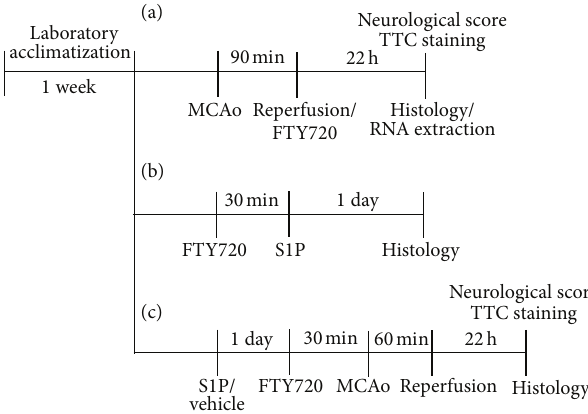
Figure 1: Schematic representation of experimental protocols. (a) Scheme for Figures 2 and 4 (an initial stroke model). Mice were challenged by 90min occlusion followed by 22 h reperfusion. FTY720 (3 mg/kg, i.p.) was administered to mice immediately after reperfusion. (b) Scheme for Figure 3. S1P was microinjected into the corpus callosum (CC) and brain samples were prepared 1 day after microinjection. FTY720 was administered 30 min prior to S1P microinjection. (c) Scheme for Figures 5 to 7 (a recurrent stroke- mimicking model). S1P was at first microinjected into the CC. One day later, mice were challenged by 60 min occlusion followed by 22 h reperfusion. FTY720 (3 mg/kg, i.p.) was administered to mice 30 min prior to